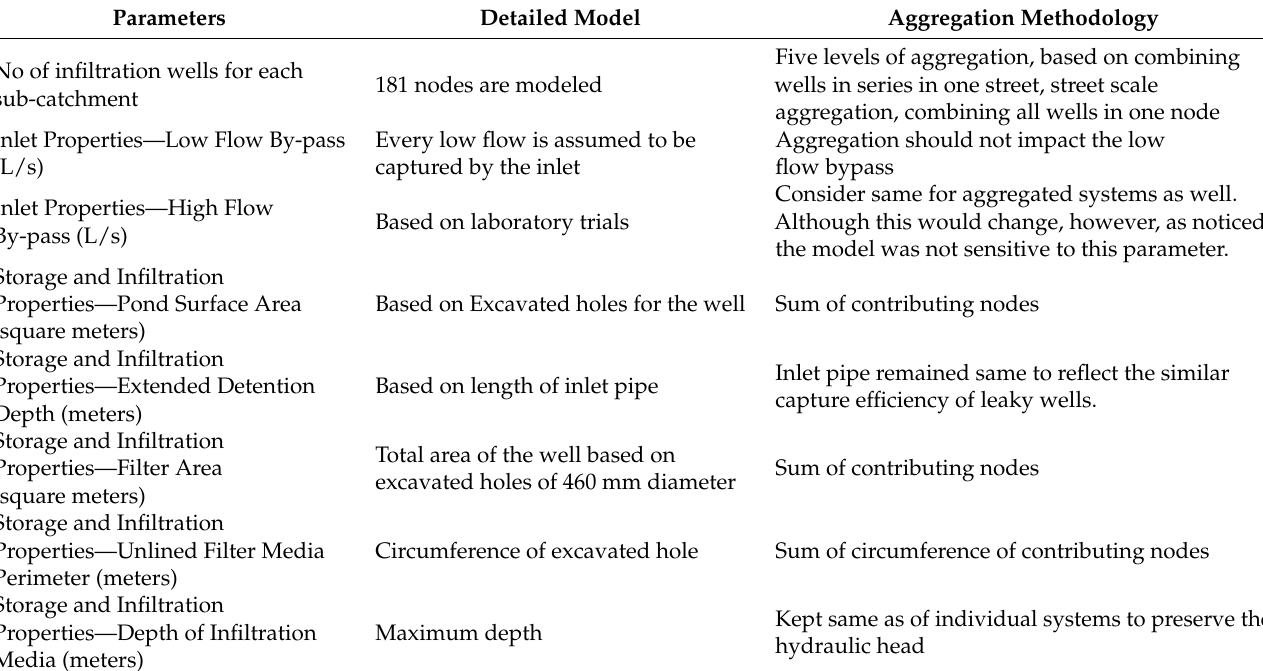
Table 2. Methodology for estimating parameters for individual and aggregated values of the infiltra- tion